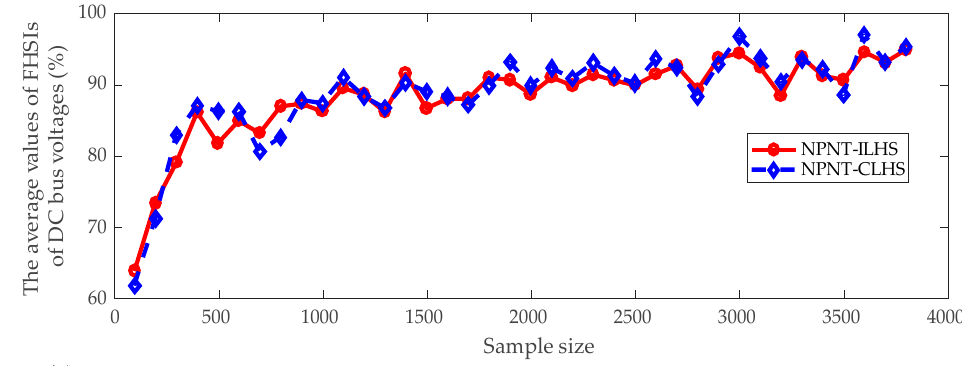
Figure 9. The average values of FHSIs of DC bus voltage obtained by using ILHS and CLHS methods.